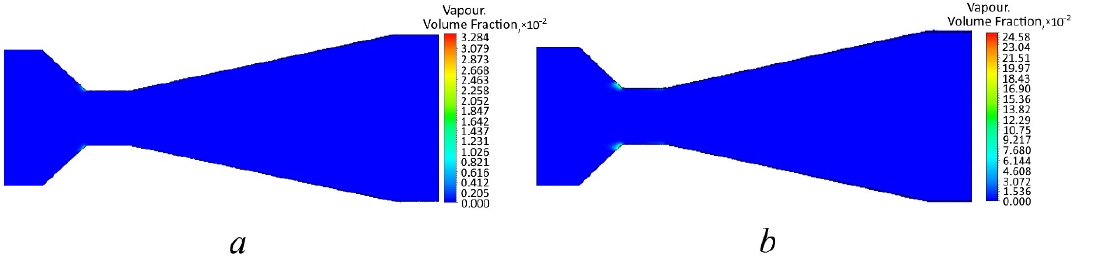
Figure 8. Numerical results for reversed flow in Venturi tube. ( a ) inlet pressure 1.5 atm ( b ) inlet pressure 1.65 atm.